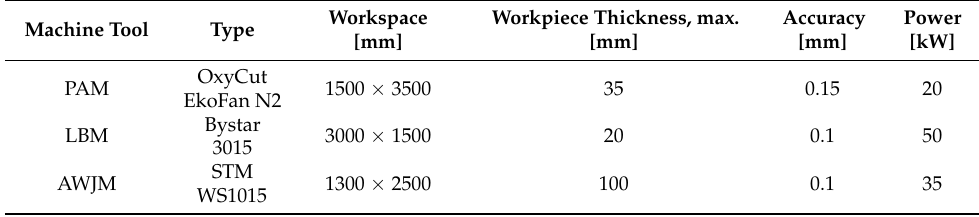
Table 3. Types of machining